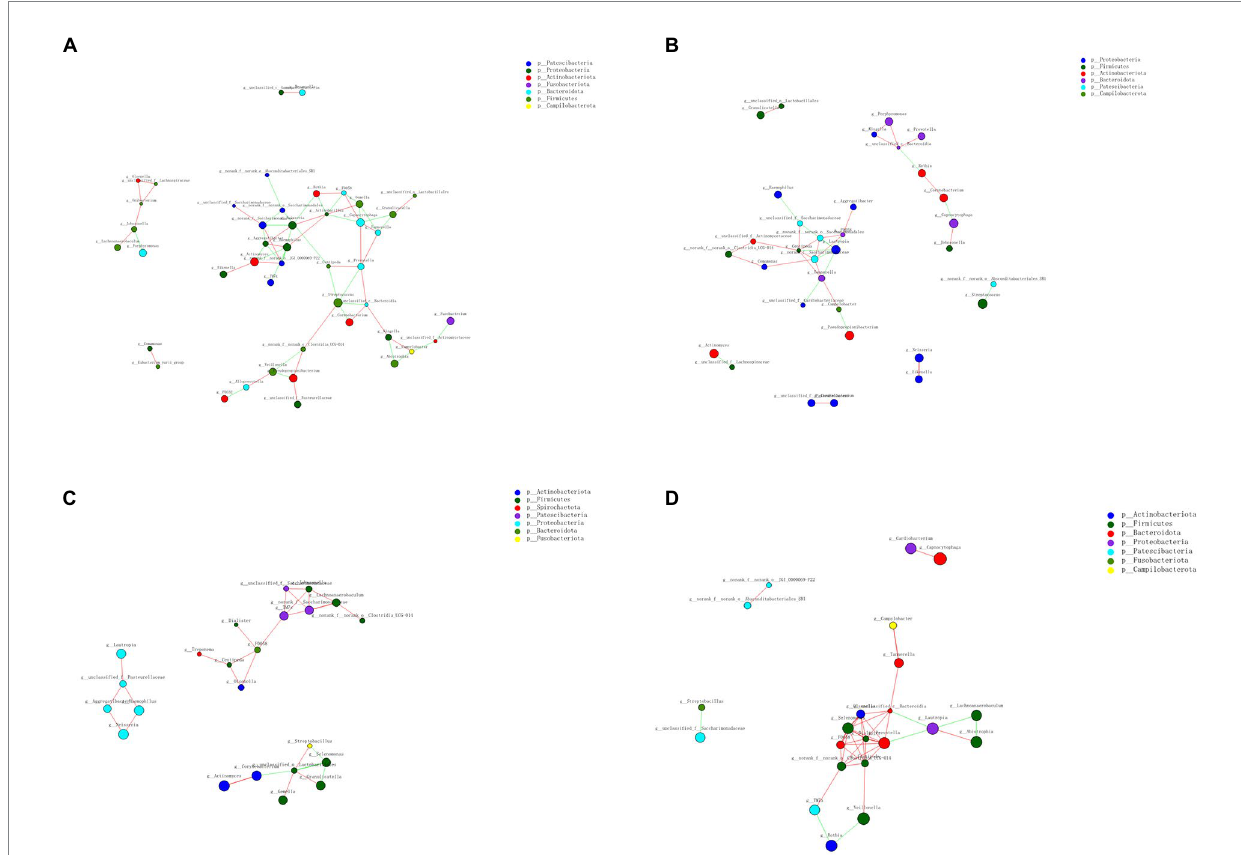
FIGURE 8 Network analysis revealed interactions of the 50 richest genera (|Spearman coefficientSpearmanCoef| > 0.8, p < 0.01). Bacterial interactions in (A) BCP, (B) BP, (C) CP, and (D) P